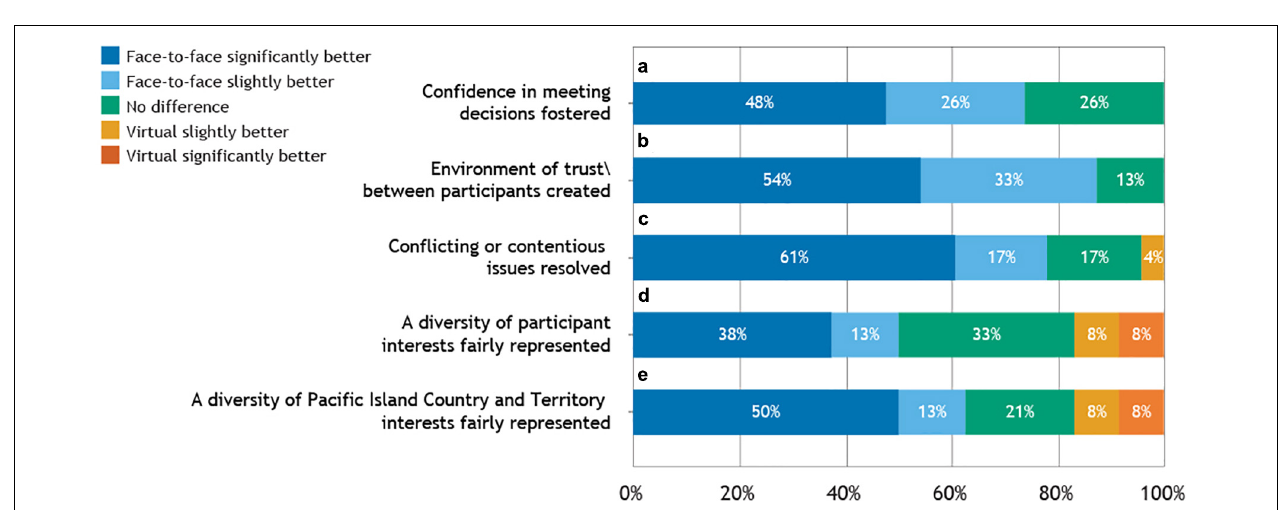
FIGURE 4 | Responses ( n = 24) to How would you rate the meeting formats (face-to-face or virtual) at supporting the following meeting outcomes?